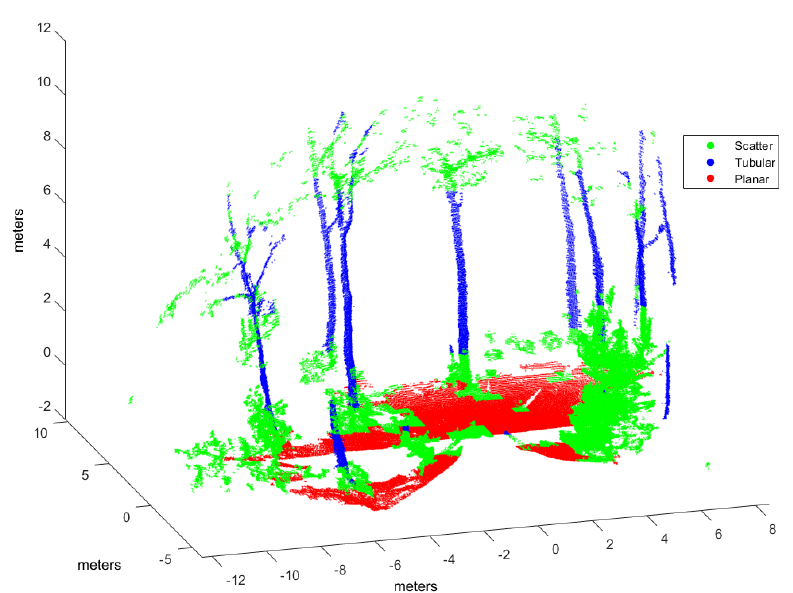
Figure 4. Hand labeled Natural_2 point cloud.